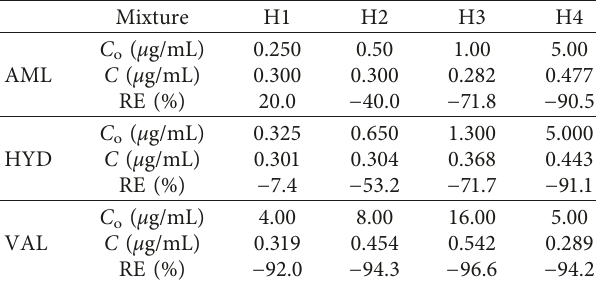
Table 3: Quantification results of AML, HYD, and VAL in a mixture using the Kalman filter with the assumption of initial guesses method (Solution